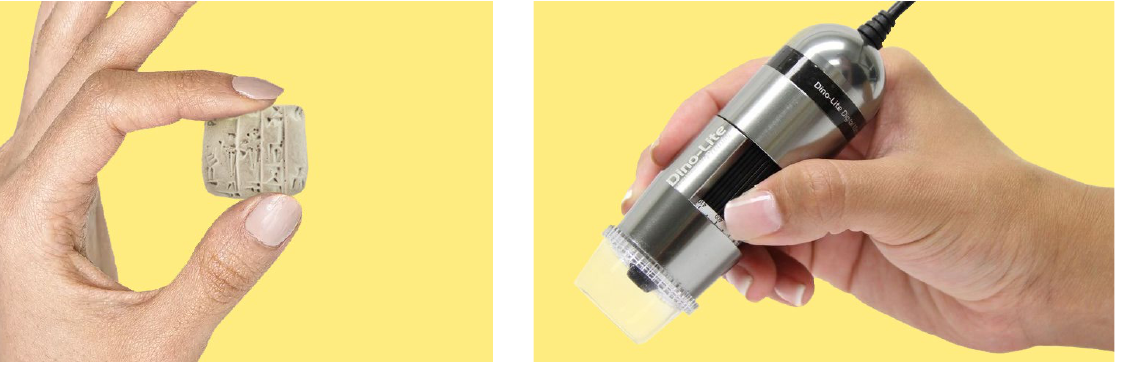
Figure 1 . Recto of the 3D printed copy of the cuneiform tablet. Figure 2 . Dino-Lite handheld digital microscope.